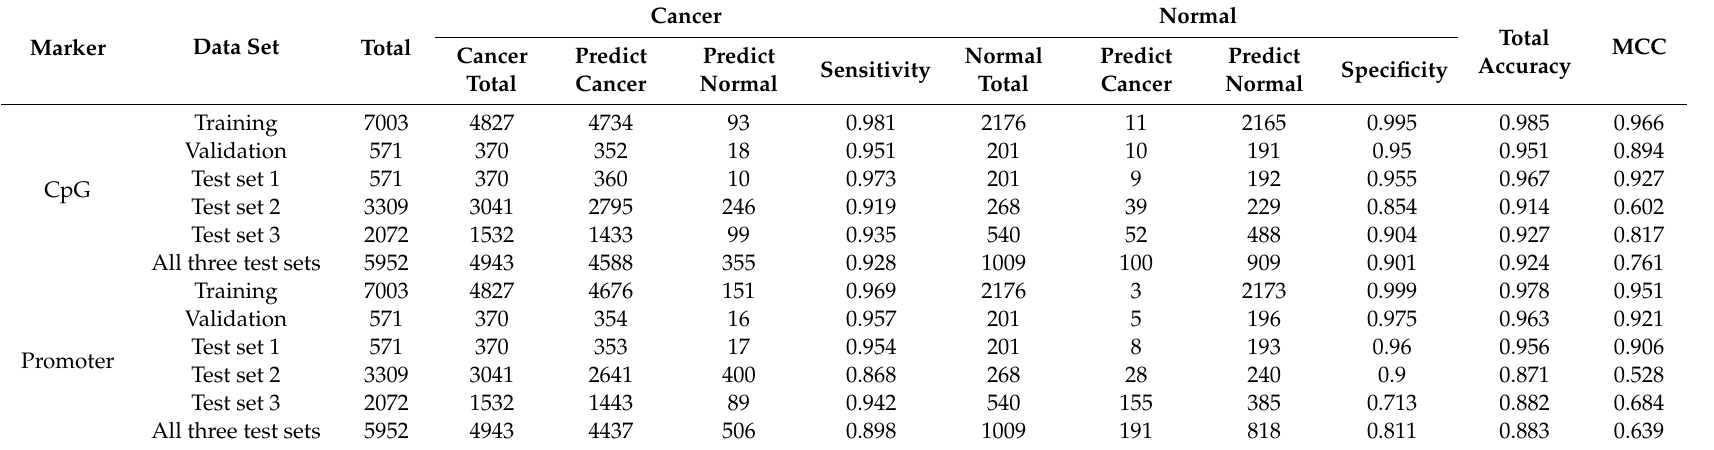
Table 3. The summary of all prediction